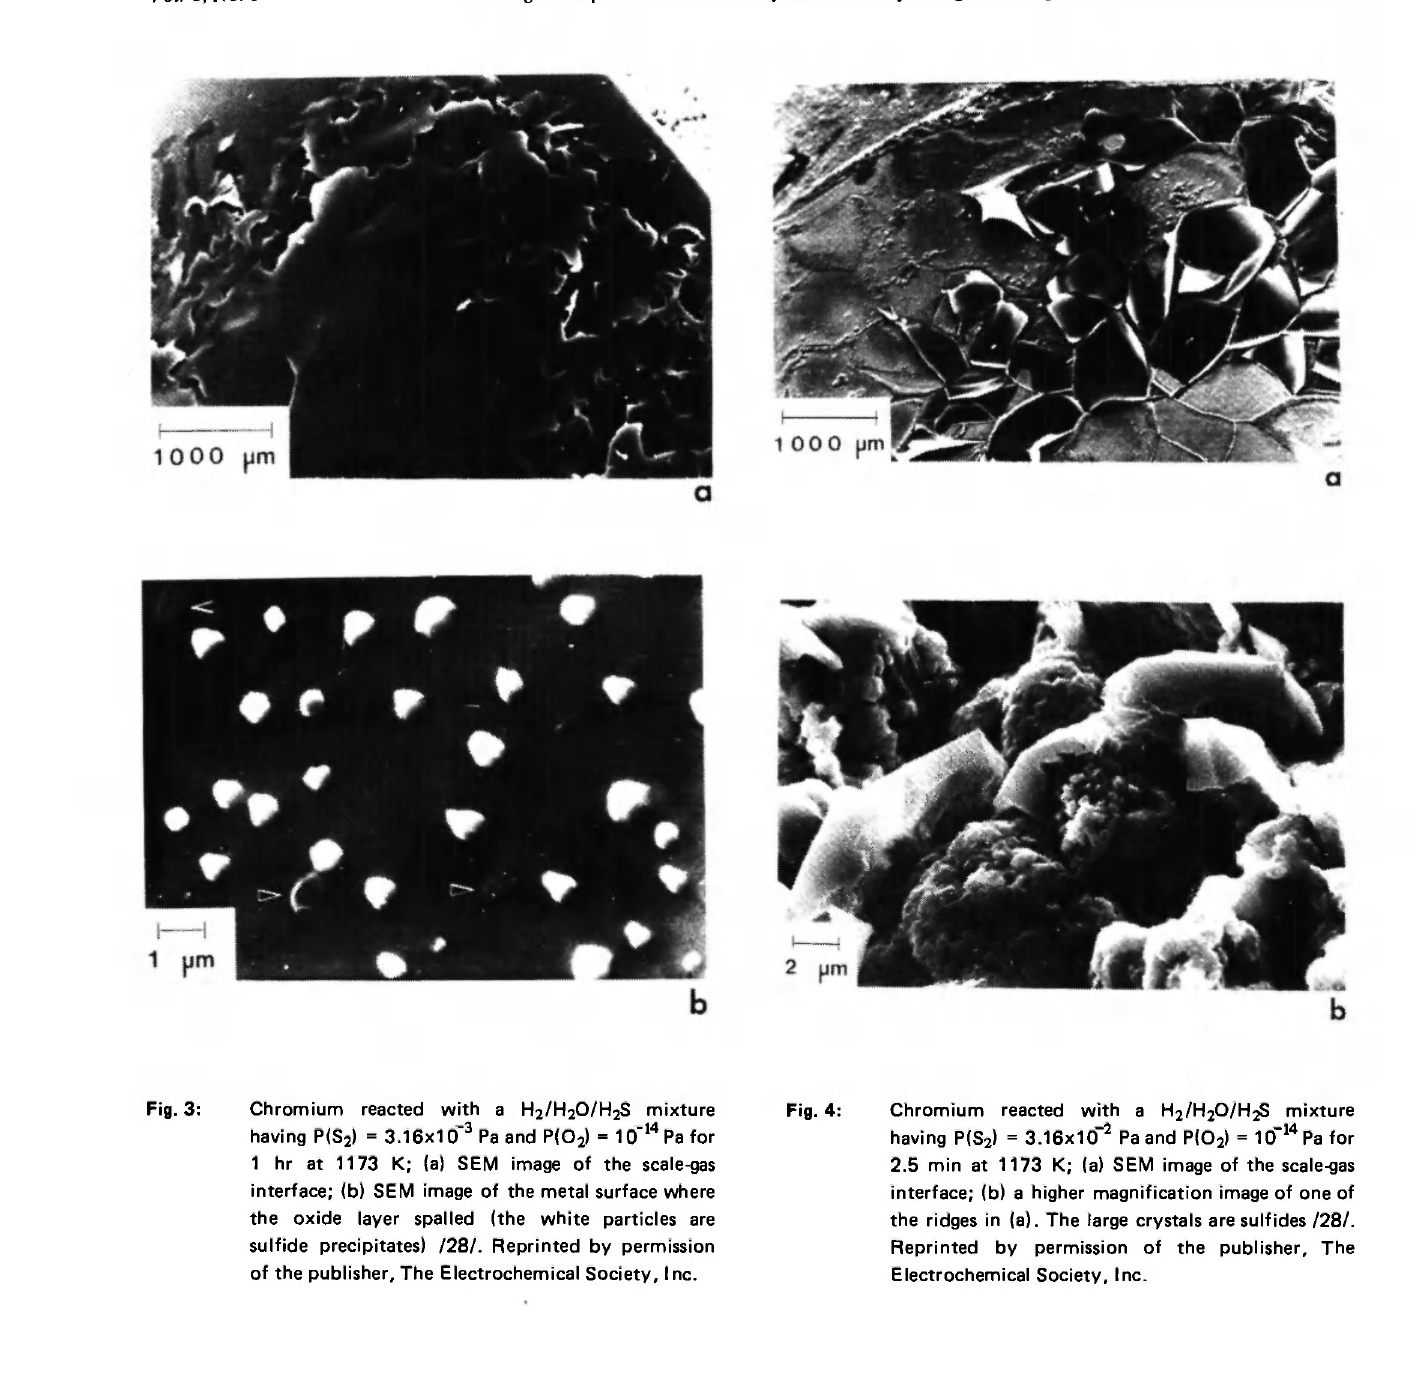
Fig. 4: Chromium reacted with a K^/HjO/HiS mixture having P(S 2 ) = 3.16x1Ö~ 2 Pa and P(0 2 ) = 10~ l4 Pafor 2.5 min at 1173 K; (a) SEM image of the scale-gas interface; (b) a higher magnification image of one of the ridges in (a). The large crystals are sulfides /28/. Reprinted by permission of the publisher. The Electrochemical Society,